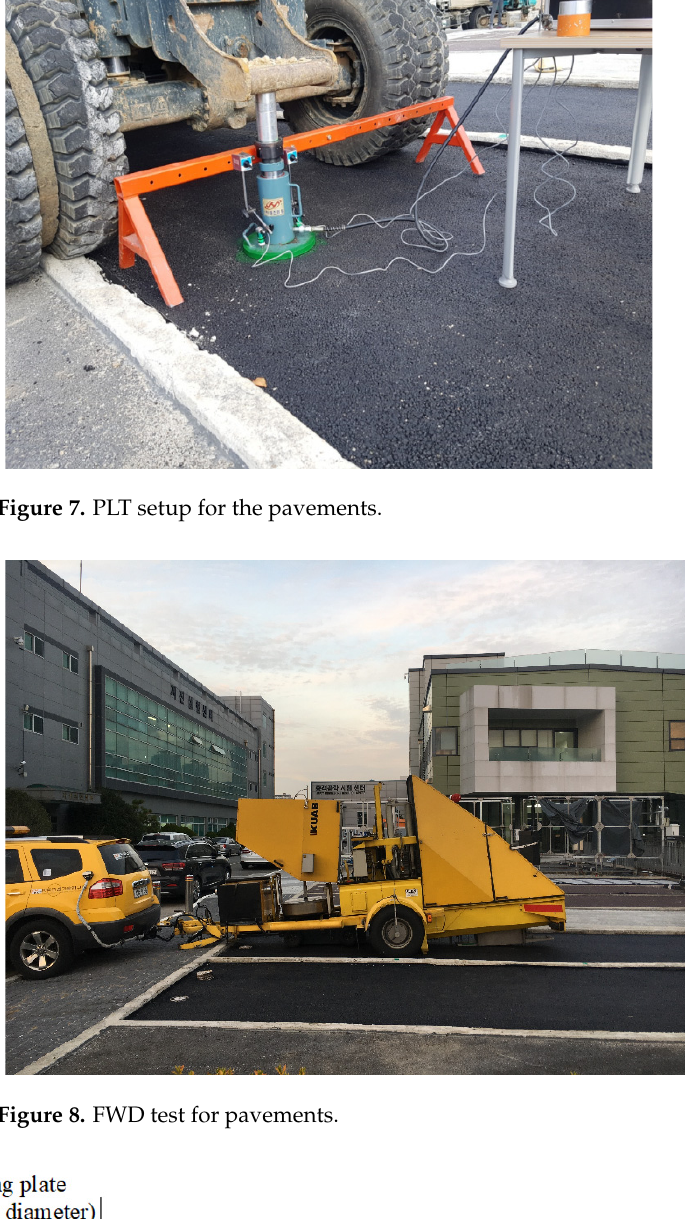
Figure 7. PLT setup for the pavements.